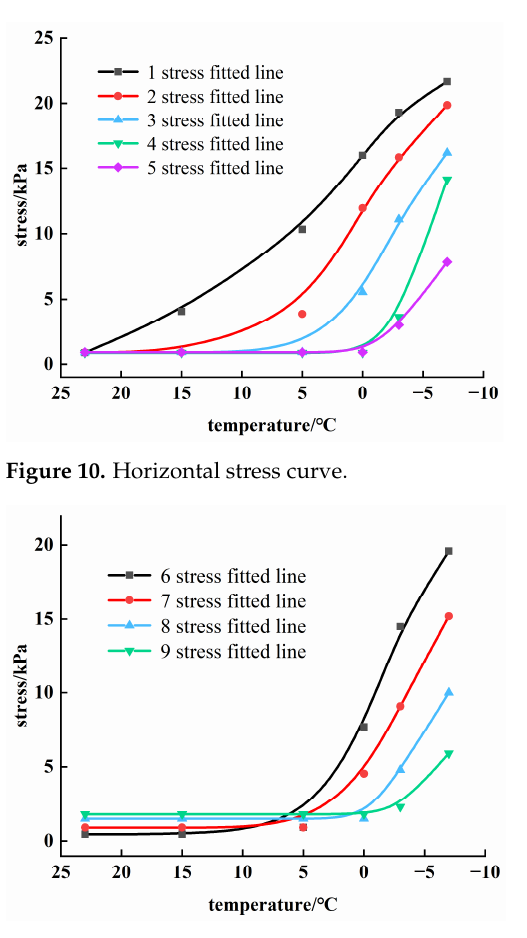
Figure 11. Vertical stress curve.